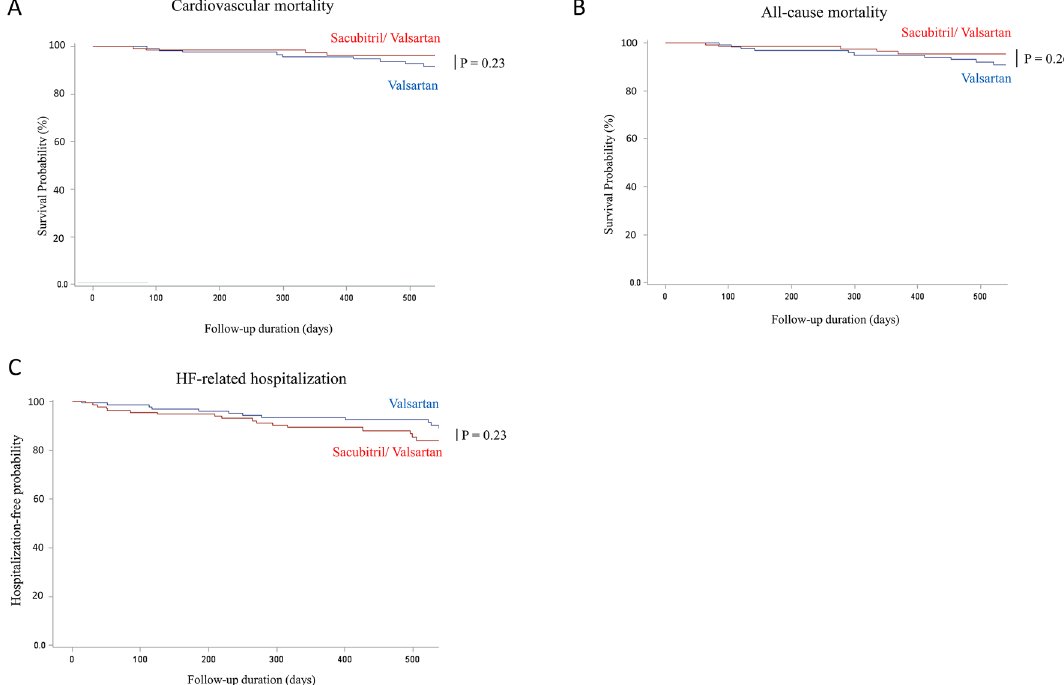
Figure 4. Kaplan–Meier curve for cardiovascular outcomes. ( A ) cardiovascular mortality, ( B ) all-cause mortality, and ( C ) heart failure-related hospitalization. P value calculated by log-rank